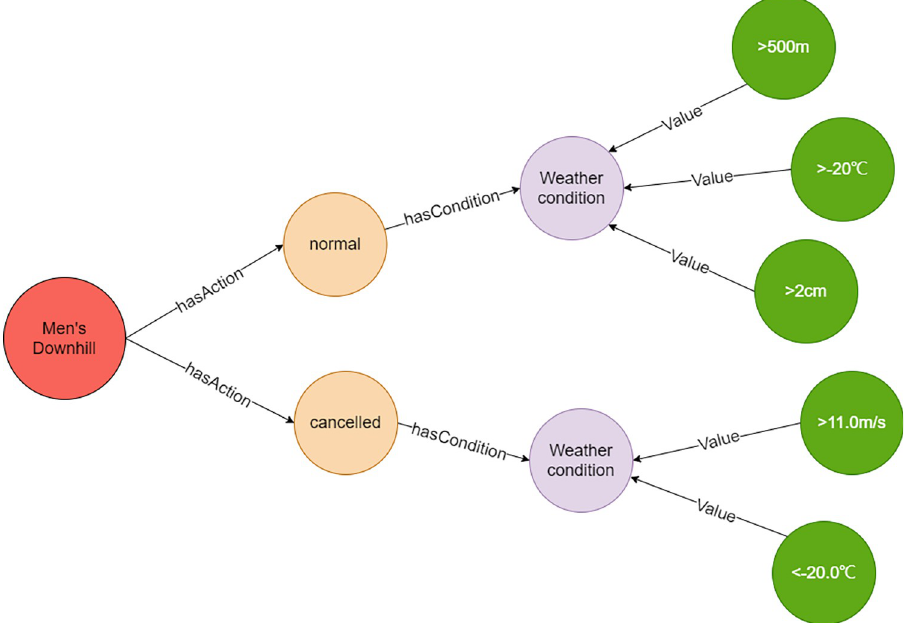
Fig 9. Multiple meteorological condition for event to be cancelled or